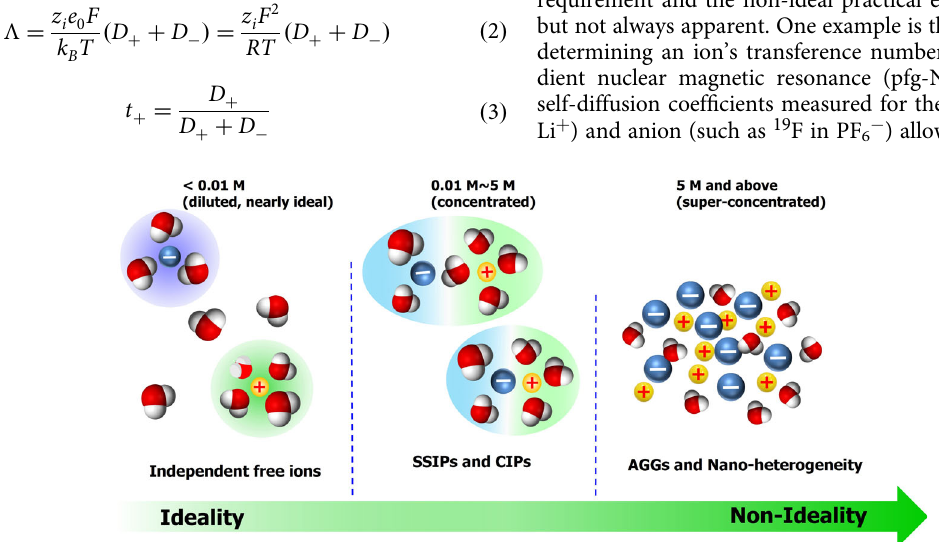
Fig. 1 The ideality requirement of electrolyte is not met at practical salt concentrations. The electrolyte ideality can only be approximately approached at extremely diluted solutions (<0.01 M); at concentrations above 0.01 M, the cations and anions are so strongly interacting with each other that ion-pairs form; at moderate concentrations (0.01 – 0.5 M) solvent-separated ions (SSIP) and close ion-pairs (CIP) coexist; at super-concentrations (>5 M), the aggregates (AGG) and nano-heterogeneity arise and constitute the extended solution